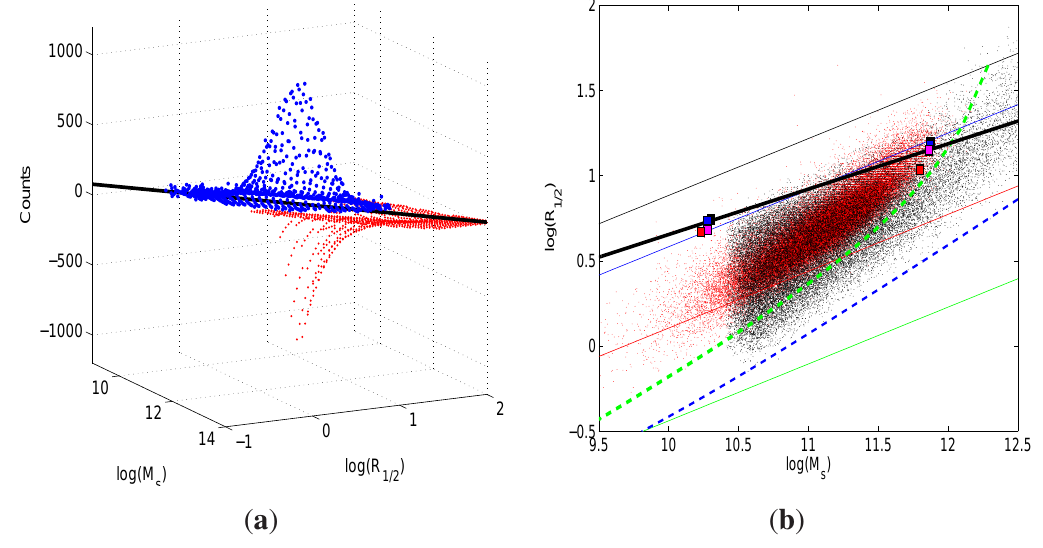
( a ) Comparison of the theoretical (red dots, negative Z -axis) with the observational (blue dots, positive Z -axis) number frequency distributions of galaxies on vs. log( R the MR-plane: log M and kpc, respectively), “Counts” stands for ) (in M S 1 / 2 ⊙ n ( z ) , i.e. , the number of haloes per Mpc 3 born between z and z +∆ z . ∆ n ( z ) = n ( z +∆ z ) − The thick line is the best fit of the observational data [HB sample of 227]. The theoretical number frequencies have been plotted as negative quantities to get the mirror image of the observational data; ( b ) Monte-Carlo simulation of the MRR: comparison of the theoretical (black dots) with the observational (red dots) distributions of galaxies on the MR-plane. The theoretical simulation is for η = 0 . 01 . Superposed to it are the reference models (filled squares) for intermediate and high mass galaxies and their linear fit, and the CGS 2 haloes per ( Mpc/h ) 3 (the thick dashed green line is for the stellar component for N = 10 − h and the blue line for the DM halo). The thin trasverse lines are the [232] relationships for different redshift, namely z = 0, 5, 10, and 20 from the top to the bottom. Finally, the observational data are from [227]. Adapted from